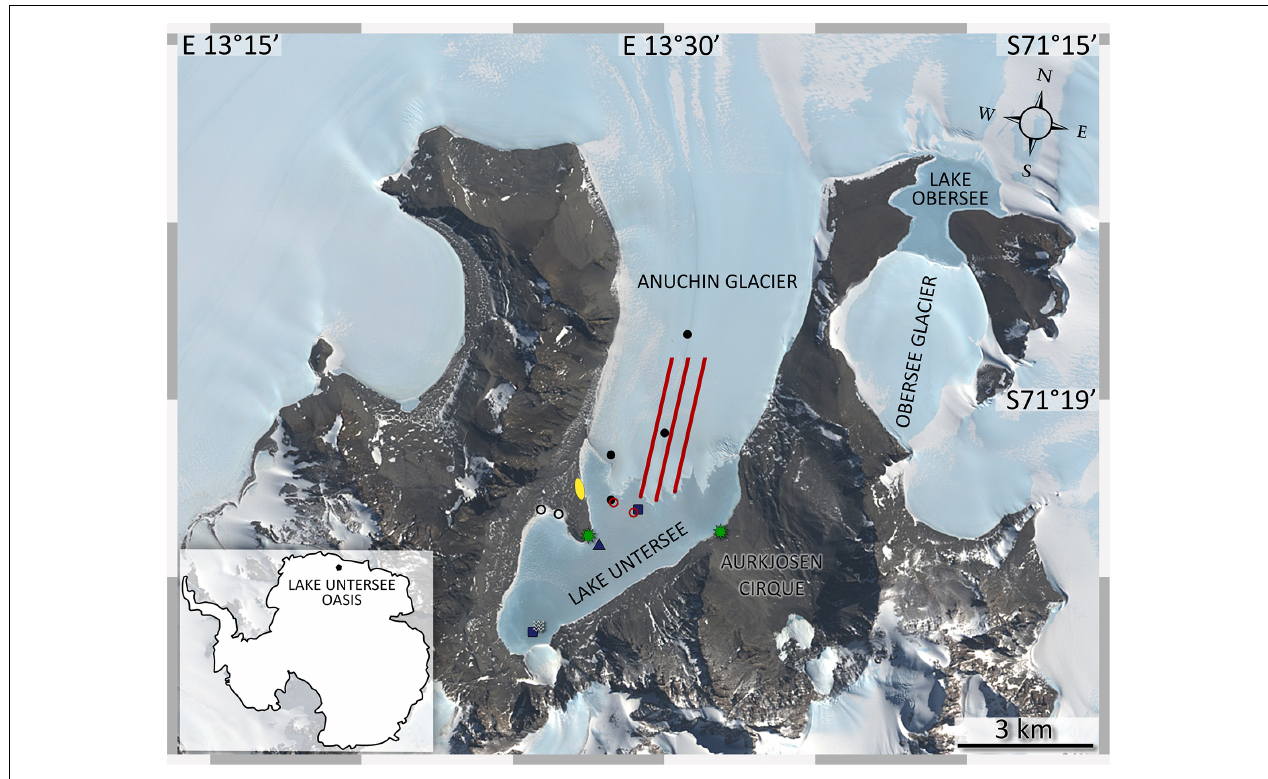
FIGURE 1 | Sampling sites at Lake Untersee Oasis. The image was captured by the Landsat 8 satellite (download via LIMA database from United States Geographical Survey) and color bands 2, 3, 4 were applied to the high-resolution band 8. Lake Untersee is dammed in the north by the Anuchin Glacier. Black dots (cryoconite holes), blue squares (lake sediments), blue triangle (benthic microbial mats), black circles (terrestrial samples), red lines (glacier ice transect, AT1-AT2-AT3 from left to right), red circles (white ice in lake ice cover and lake ice), and a white wave symbol (pelagic samples) indicate the sampling sites. Meteorological stations are indicated by green stars. The yellow ellipse marks the campsite. Overlapping symbols indicate that the sampling site for different sample types was identical.